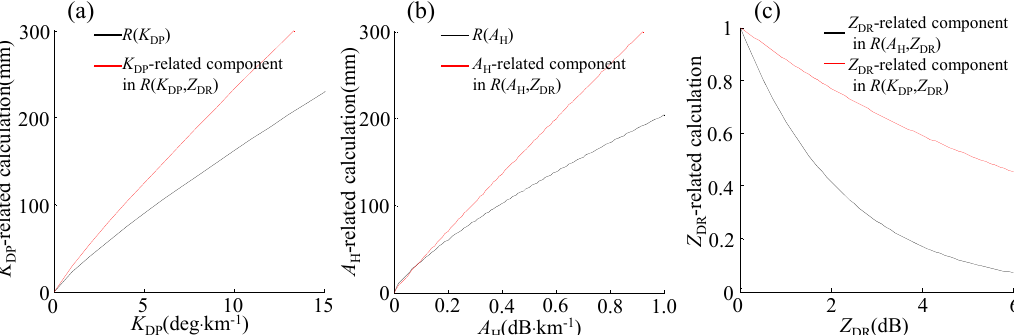
Figure 9. Different radar variable related components: ( a ) K DP -related component; ( b ) A H -related component; ( c ) Z DR -related component.